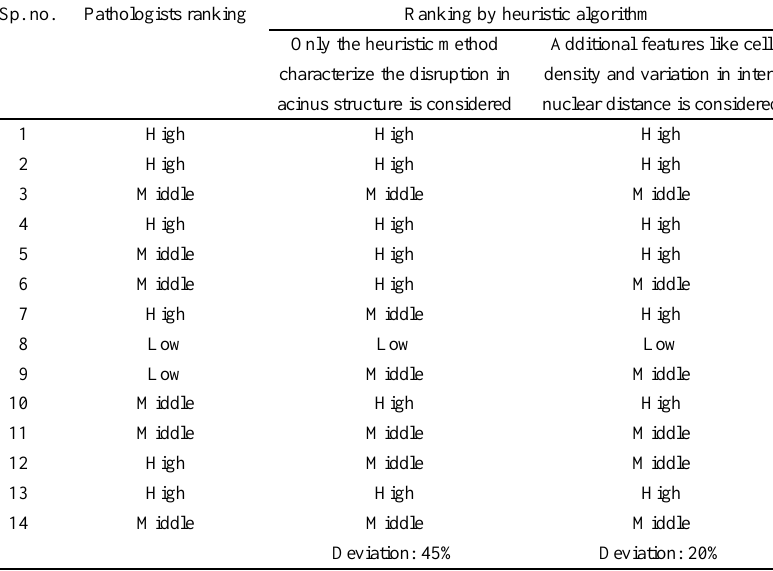
Comparative study of disruption in acinus structure. Low: Comparable to healthy tissue structure, Middle: Considerable disruption in architecture compared to healthy tissue, High: No proper glan- dular structure is observed Sp.